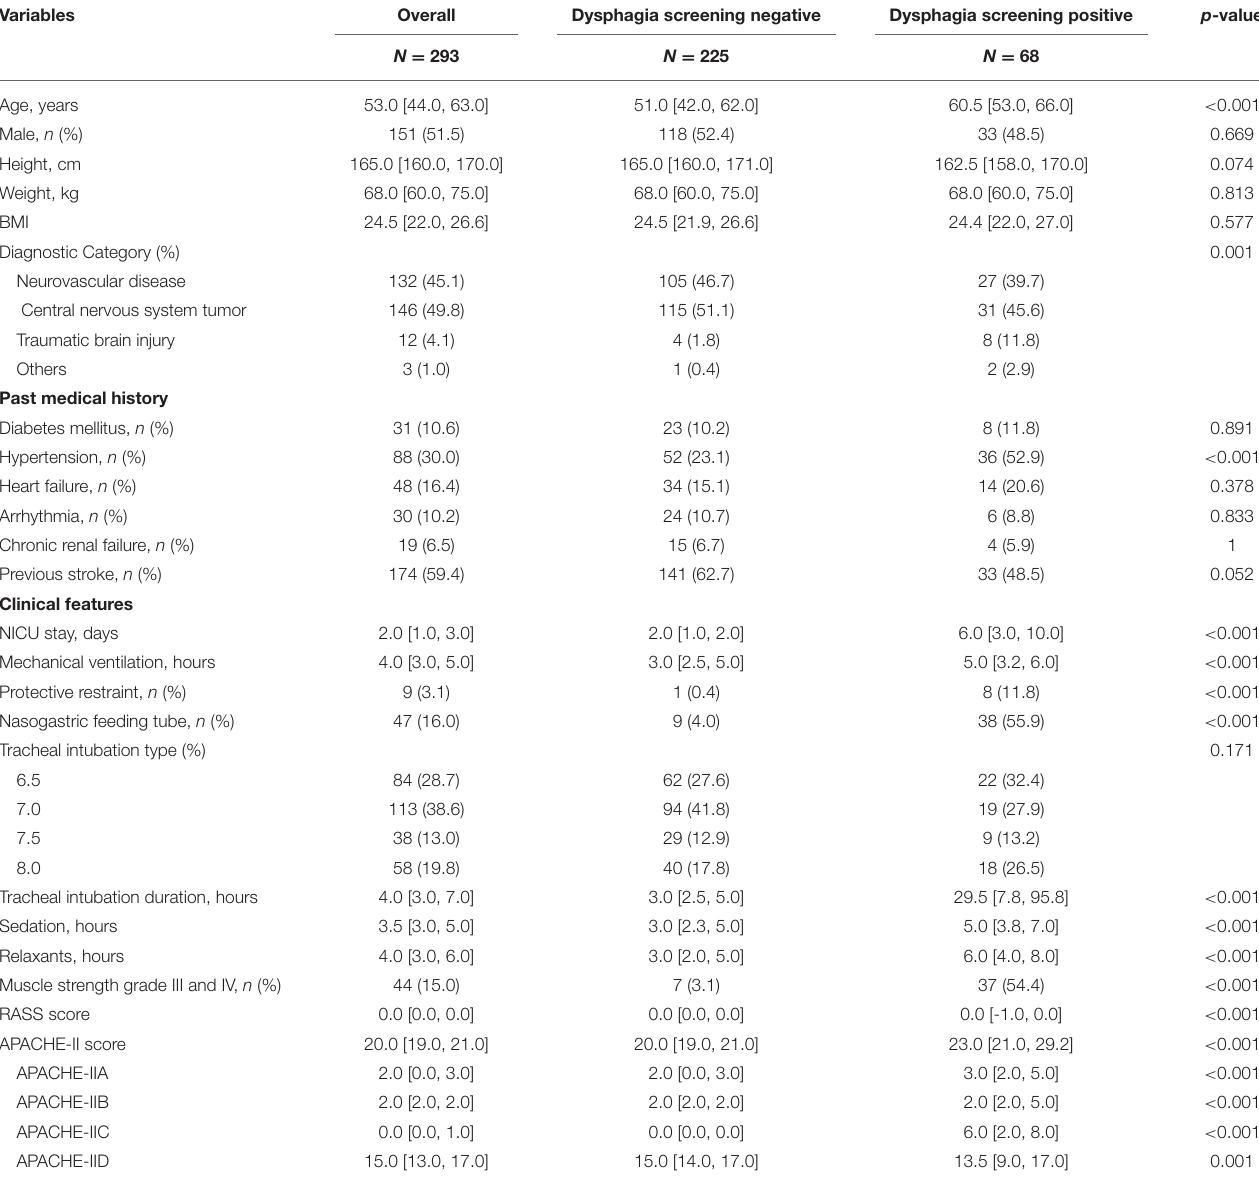
TABLE 1 | Baseline characteristics comparison between patients with dysphagia or not.